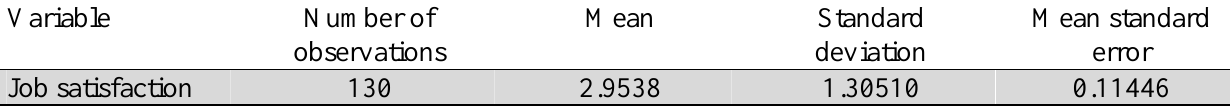
The results of observed statistics on the level of job satisfaction for high-risk jobs